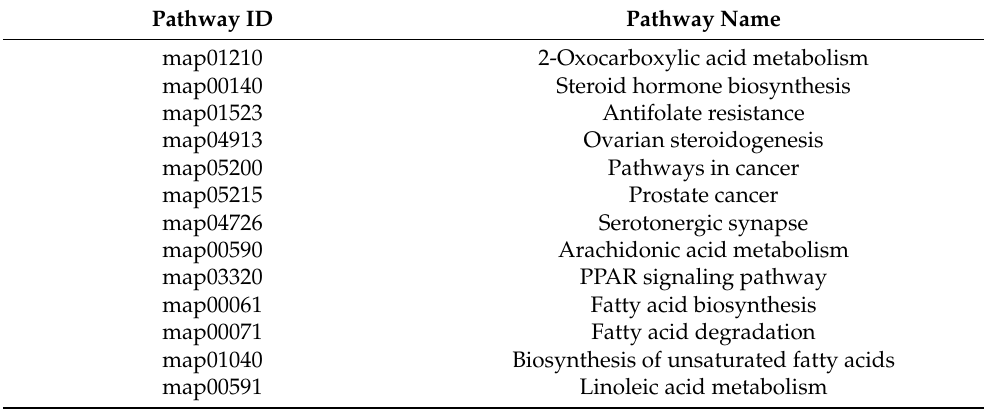
Figure 7. Venn diagram of DAMs and KEGG enrichment analysis. ( a ) Venn diagram of DAM enrichment analysis between each comparison group. ( b ) Wayne diagram of enrichment signaling pathway in each comparison group. A: control group; B: treadmill group; C: acupoint catgut embedding group 1; D: acupoint catgut embedding group 2. DAMs: differentially accumulated metabolites; KEGG: Kyoto Encyclopedia of Genes and Genomes. Table 3. Common signaling pathways in three comparison groups.